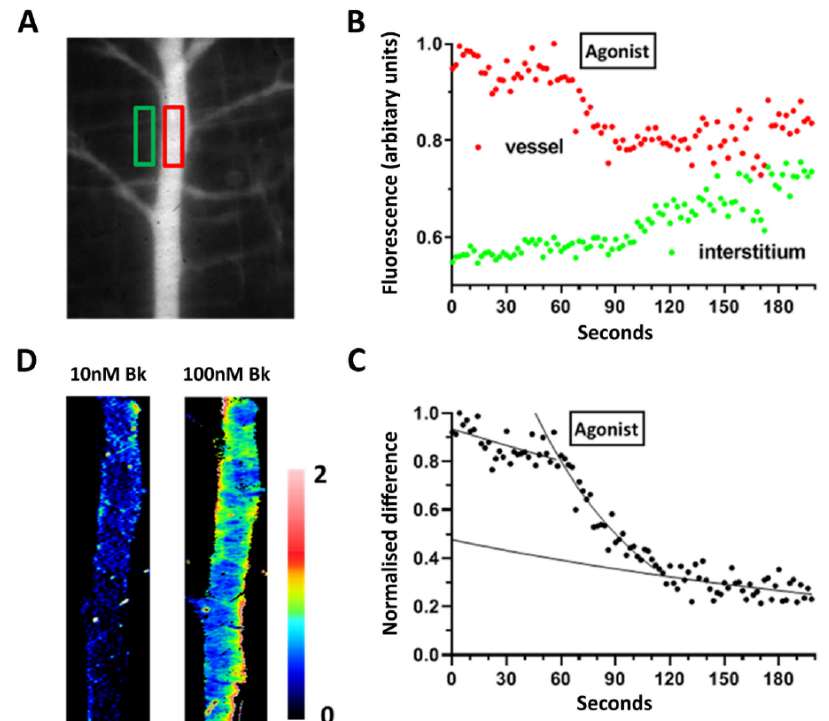
Figure 1. Basal and agonist stimulated permeability measurements in single venules in a rat cremaster muscle preparation. ( A ) Representative fluorescence image of the cremaster microvasculature